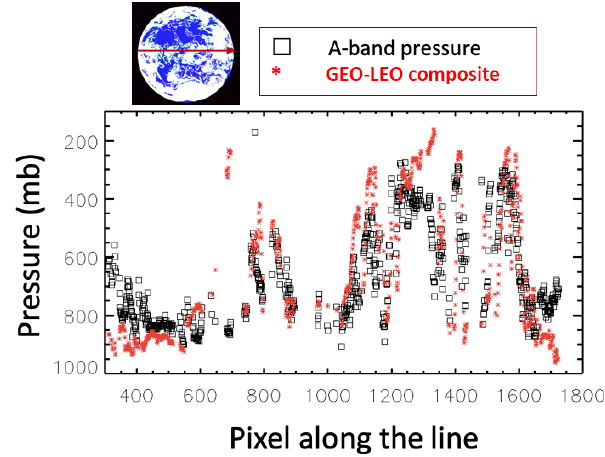
Figure 8. Comparison of EPIC A-band CEP with the co-located GEO–LEO retrievals for the same granule as Fig. 6. The compari- son is done along the red arrow shown on the cloud mask thumbnail at top.